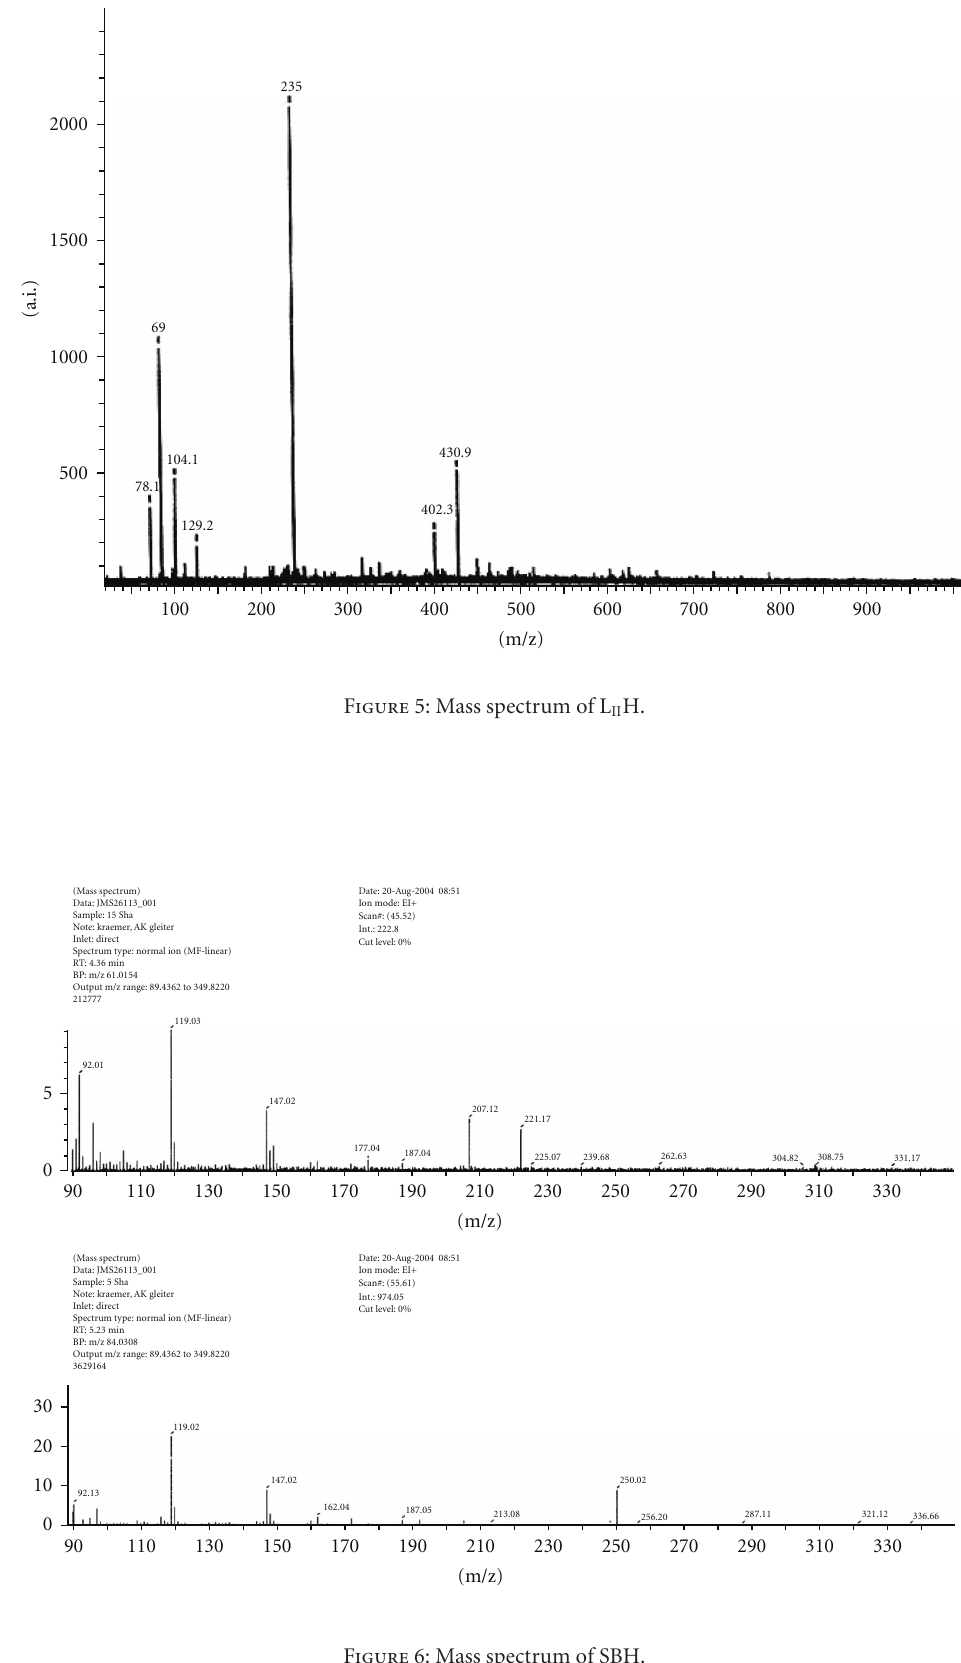
Figure 6: Mass spectrum of